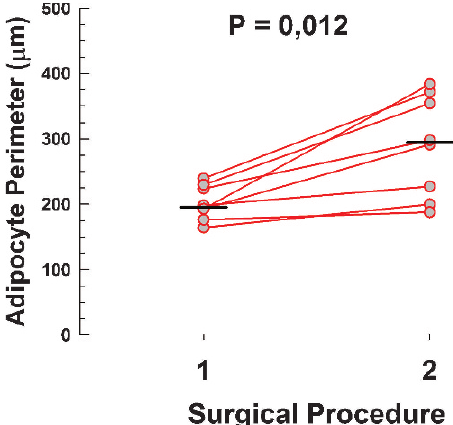
Figure 4 - Scoter plot with lines showing the variation of the adipocyte area between surgical procedure 1 and 2. Short thick lines represent the series median values.